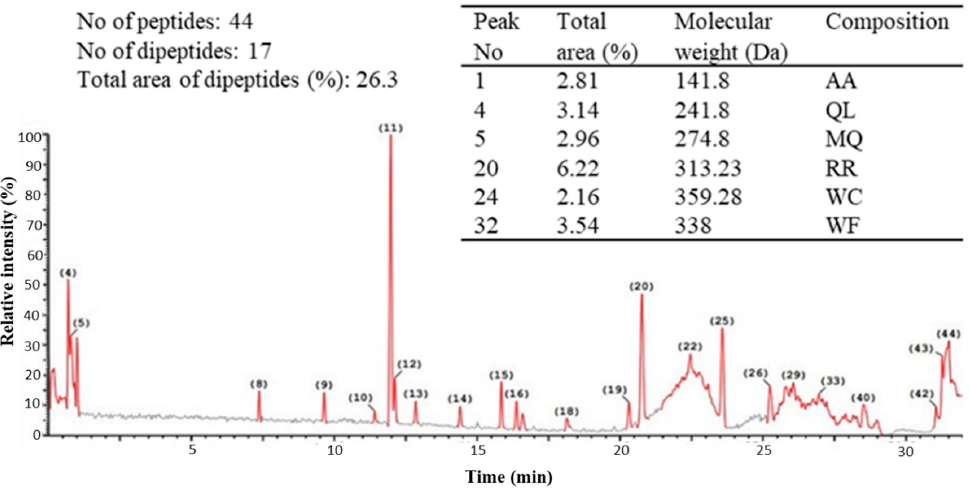
Figure 3. Chromatogram of peptides formation from egg albumin hydrolyzed with pepsin and the mass spectrum of major peaks